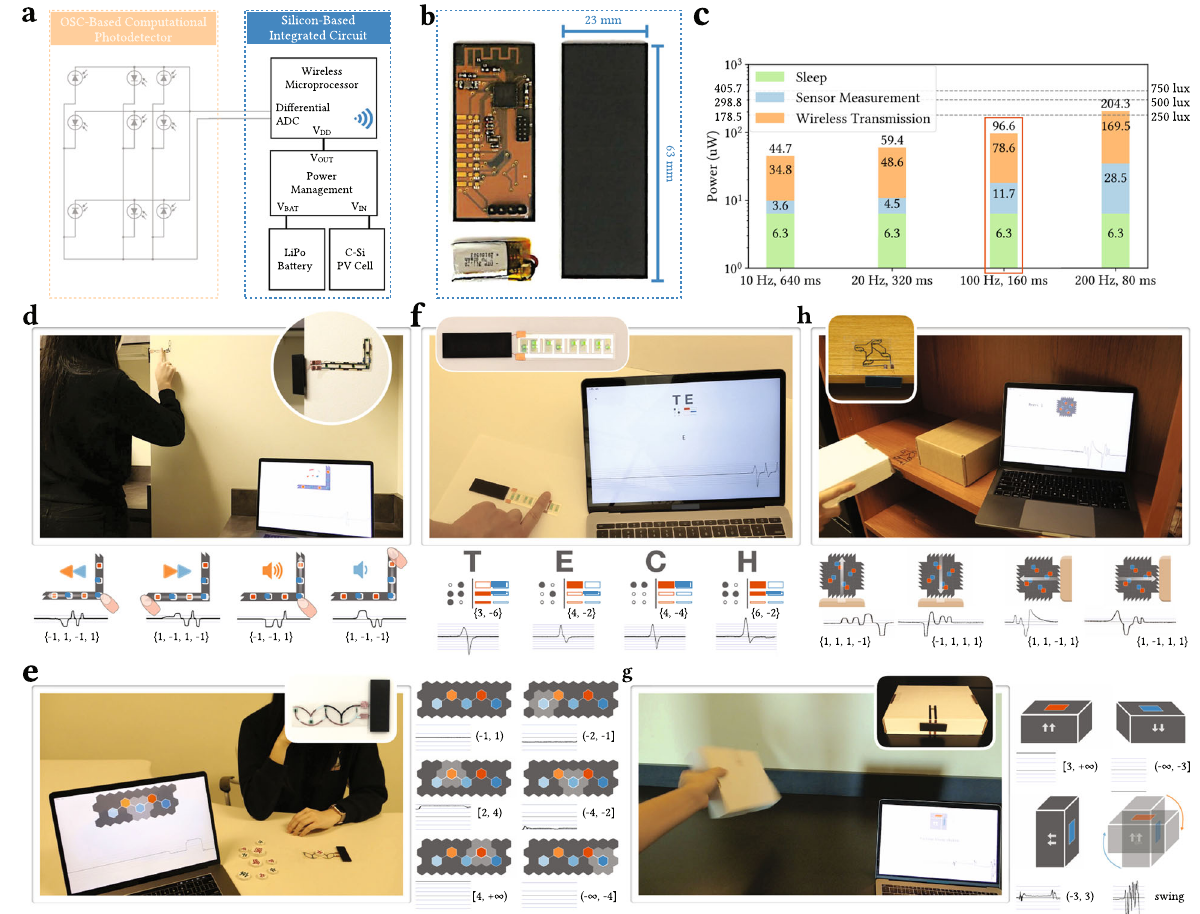
Fig. 6 System and applications. a Schematics of the self-powered wireless sensing system compatible with various computational photodetector designs. b The wireless sensing circuit and a rechargeable battery can hide behind a solar cell. c Power consumption and harvesting characteristics: 100 Hertz sensor measurement frequency and 160 millisecond wireless communication interval for all applications can be powered solely by the solar cell under 250 lux. d Music player: a linear pattern can sense the fi nger swipe to switch track or adjust the volume. e Board game and buttons: a grid pattern can sense the location of a chess piece or a fi nger touch. f Braille: a combination of linear and grid patterns can be used to encode braille alphabets from fi nger motion. g Package monitoring: a grid pattern deployed on a package can sense its orientation and monitor its handling. h Inventory management: a crossing pattern deployed on a shelf rack can sense the motion direction of an